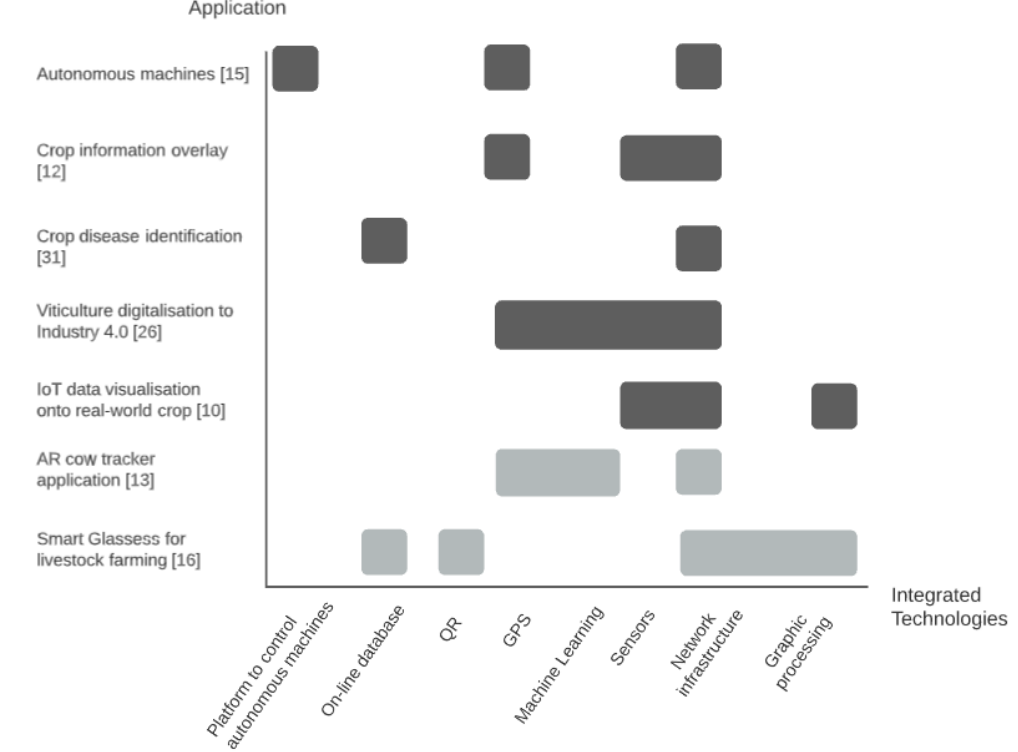
Figure 6. Comparison Analysis of Technologies Coupled with AR in Farming. Dark grey refers to crop-based articles, whereas light grey is for livestock.